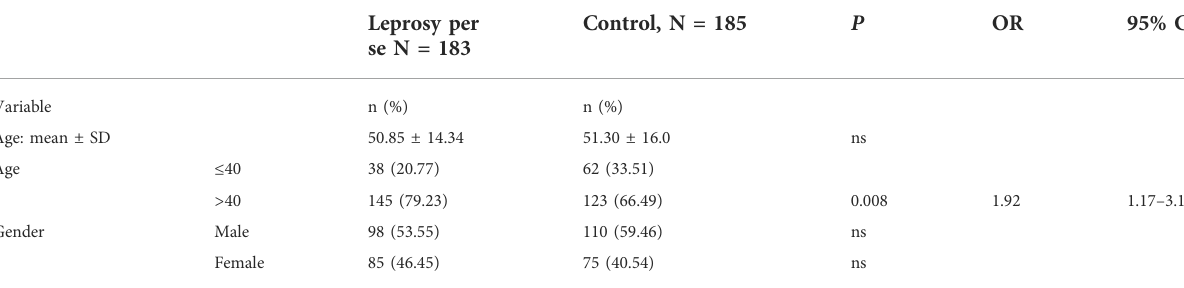
TABLE 2 Characteristics of leprosy patients and control group.